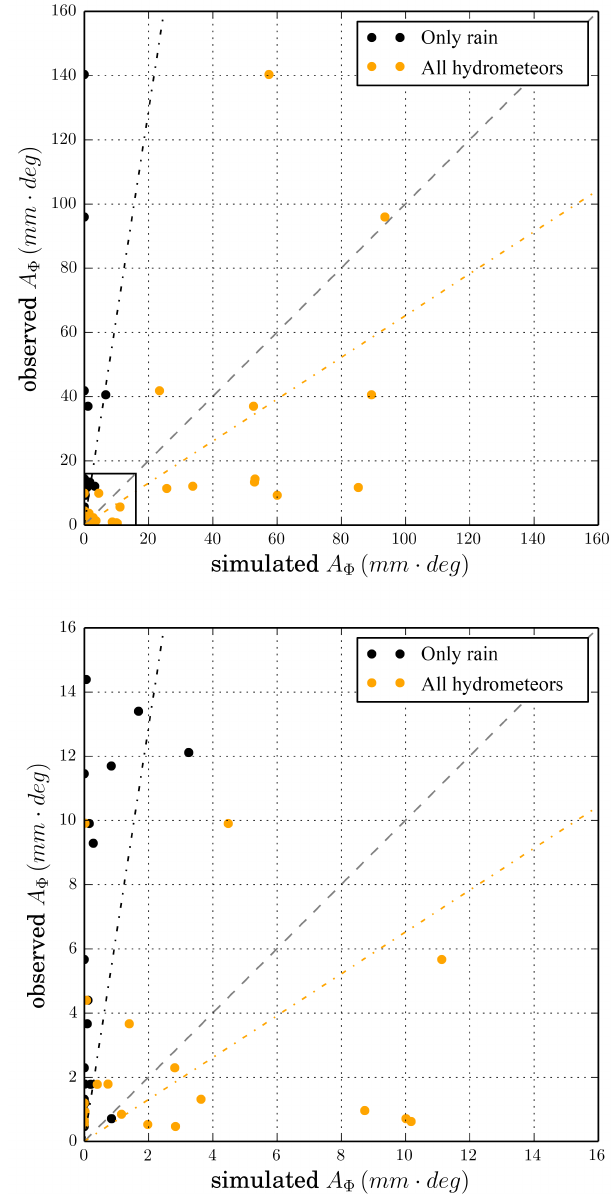
Figure 8. Top panel: observed versus simulated A (cid:56) . Bottom panel: the area where A (cid:56) < 16mmdeg in more detail. Black dots repre- sent the simulated A (cid:56) using only raindrops, while orange dots rep- resent the simulated A (cid:56) accounting for ice crystals and melting ice particles too. The dash–dot lines represent the best fitted line to the only rain A (cid:56) (black) and to the rain, ice and melting particles A (cid:56)